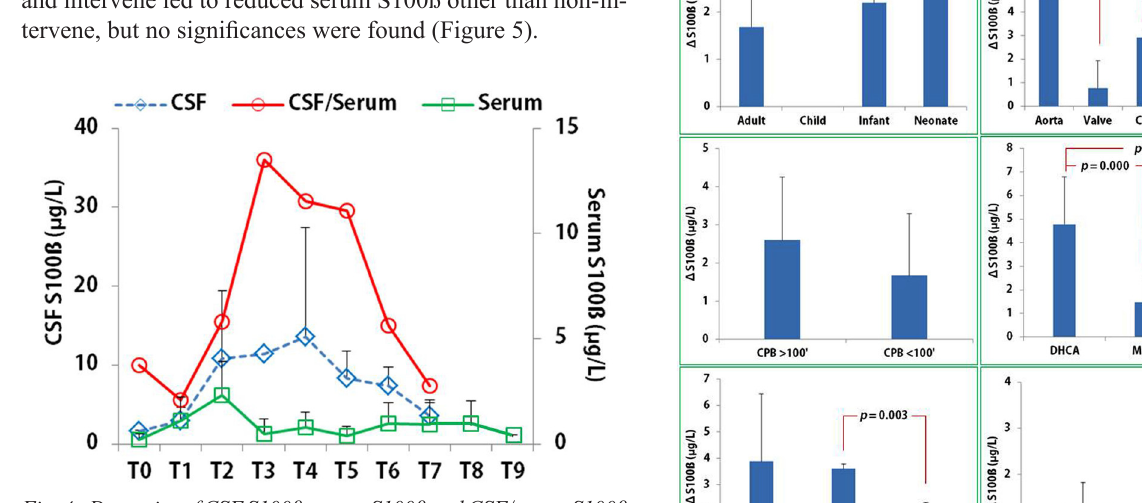
Fig. 4 - Dynamics of CSF S100ß, serum S100ß and CSF/serum S100ß ratio. CSF=Cerebrospinal fluid